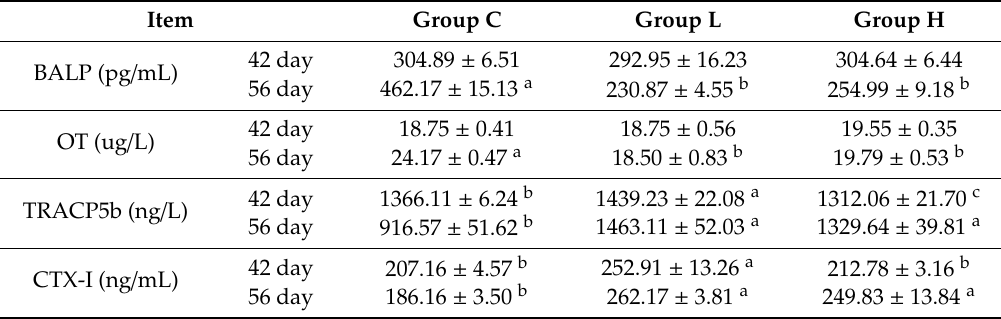
Table 5. The changes of serum indicants related to bone metabolism in broilers.